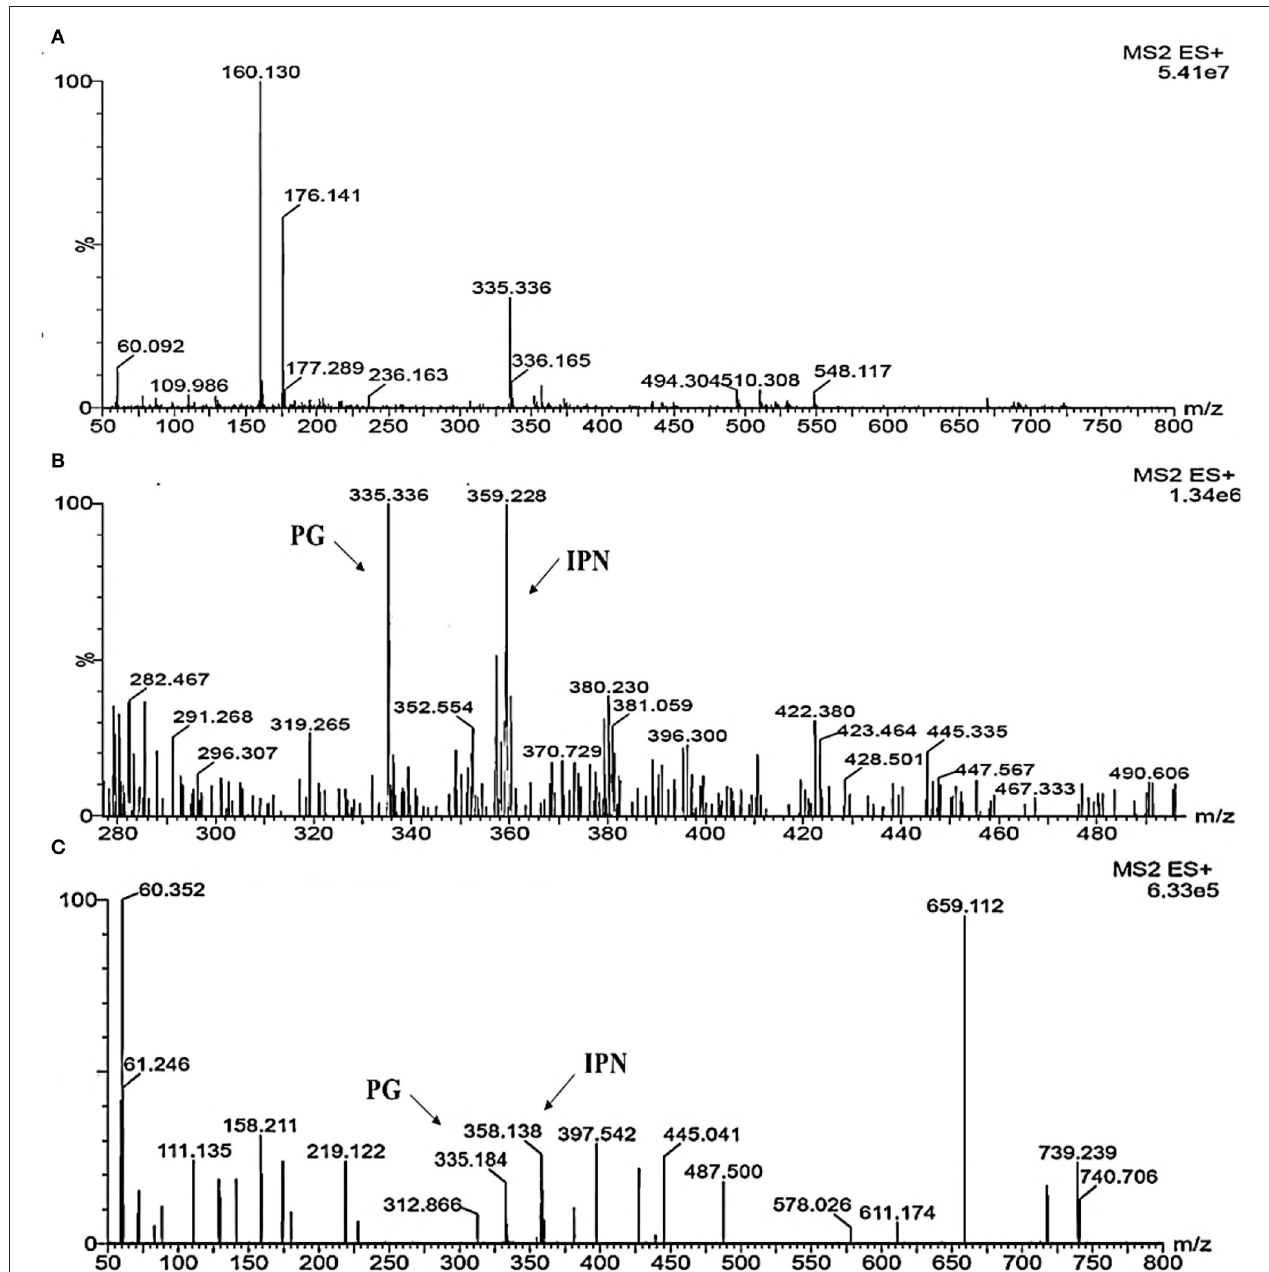
FIGURE 12 | Detection of β -metabolites detected M. ruber M7 and 1 abct 31 transformants by UPLC-MS/MS. UPLC-MS/MS spectrogram of the M. ruber M7 and 1 abct 31 for solid-state fermented on rice displays that the atomic mass of ion (m/z 335.336) matched well with the standard penicillin, the molecular weight for isopenicillin N is 359.3 g/mol, in spectrogram ion m/z 359.00 representing the isopenicillin N peak. (A) Spectra in A penicillin G (PG) standard with the mass 335.336; (B) A pattern of fragmentation of M. ruber M7; (C) A pattern of fragmentation of 1 abct 31.